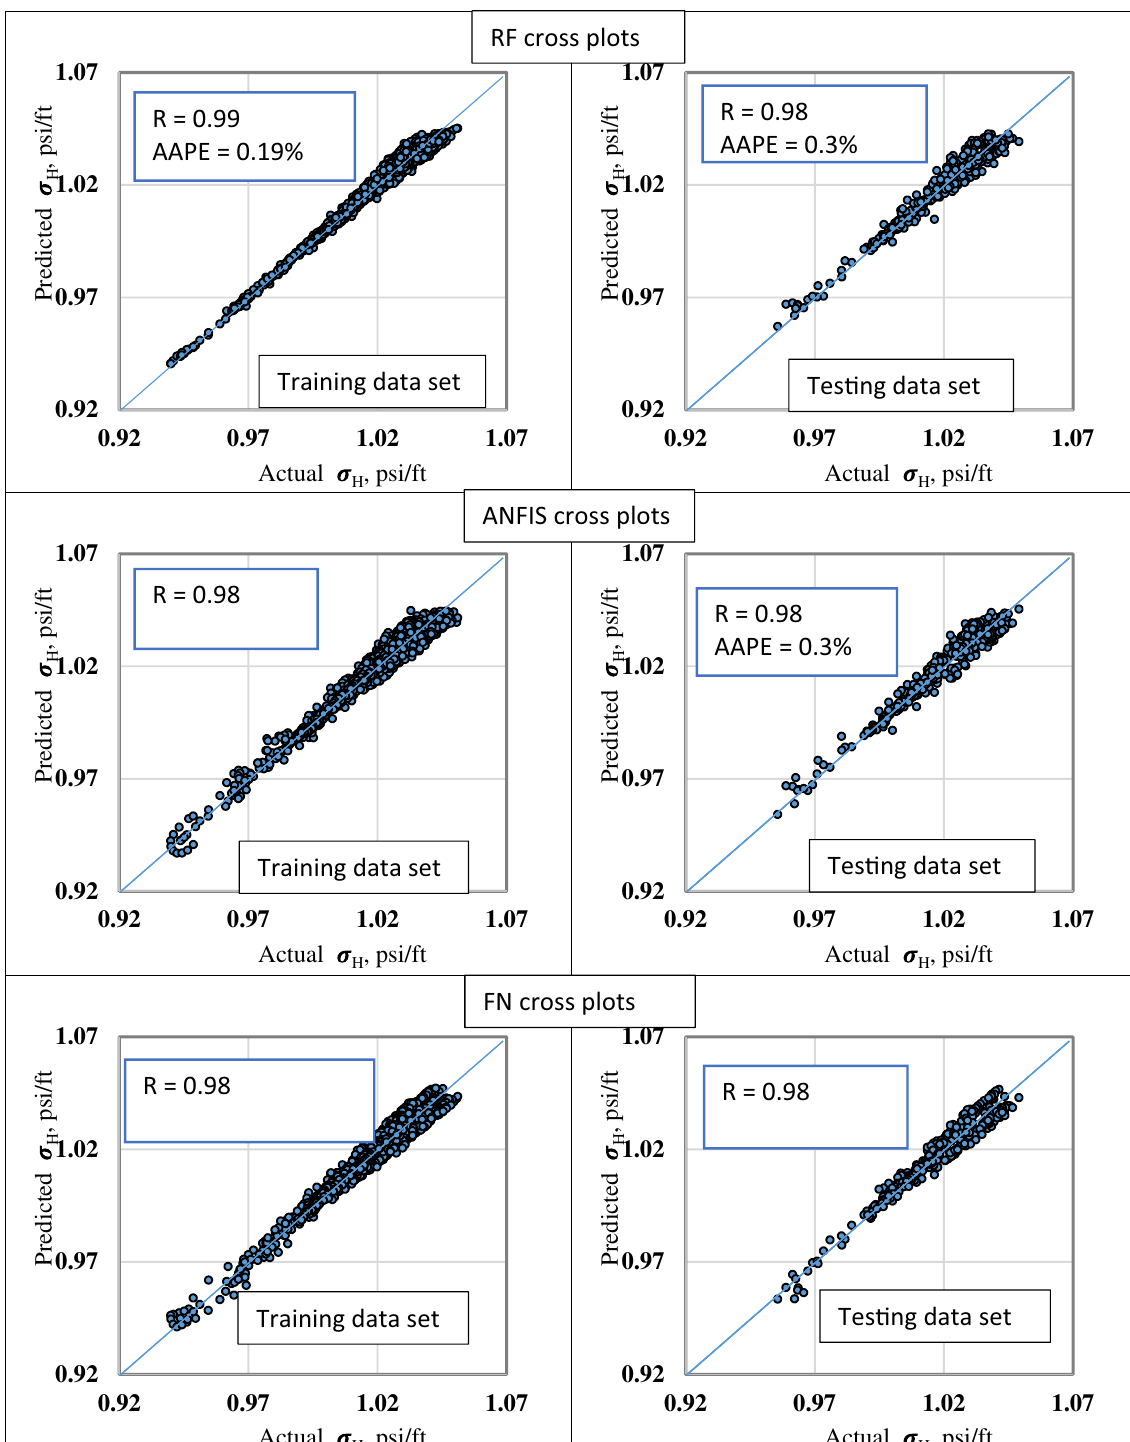
Figure 7. Cross plots of the actual versus the predicted σ H for the training and the testing datasets from RF, FN, and ANFIS